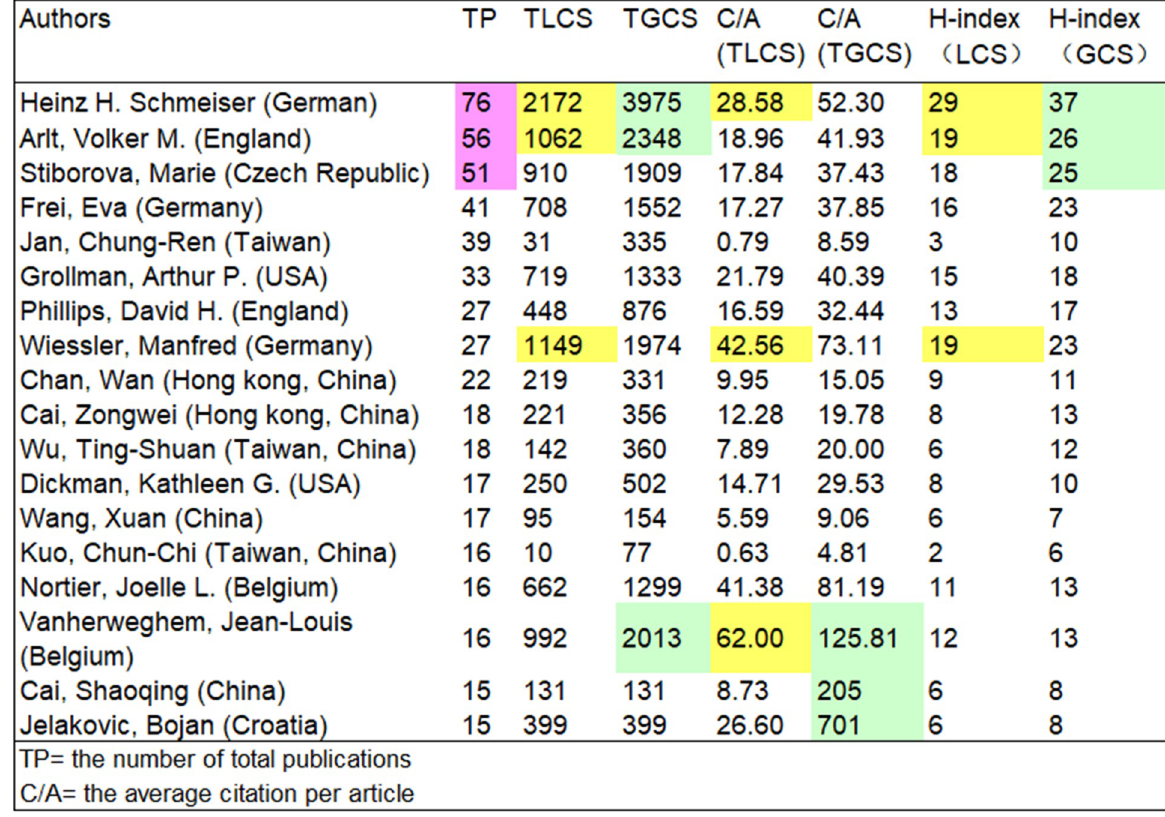
Fig 5. Authors with the highest rate of publication. The cells tinted pink, yellow, and pale green indicate the top three in each column.